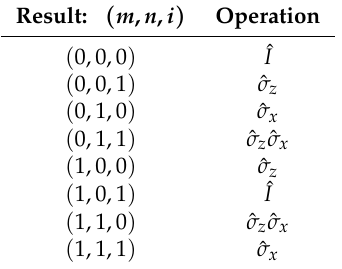
Table 3. Alice’s and Bob’s results; and the corresponding operations needed to recover the desired state. Result: ( m , n , i )